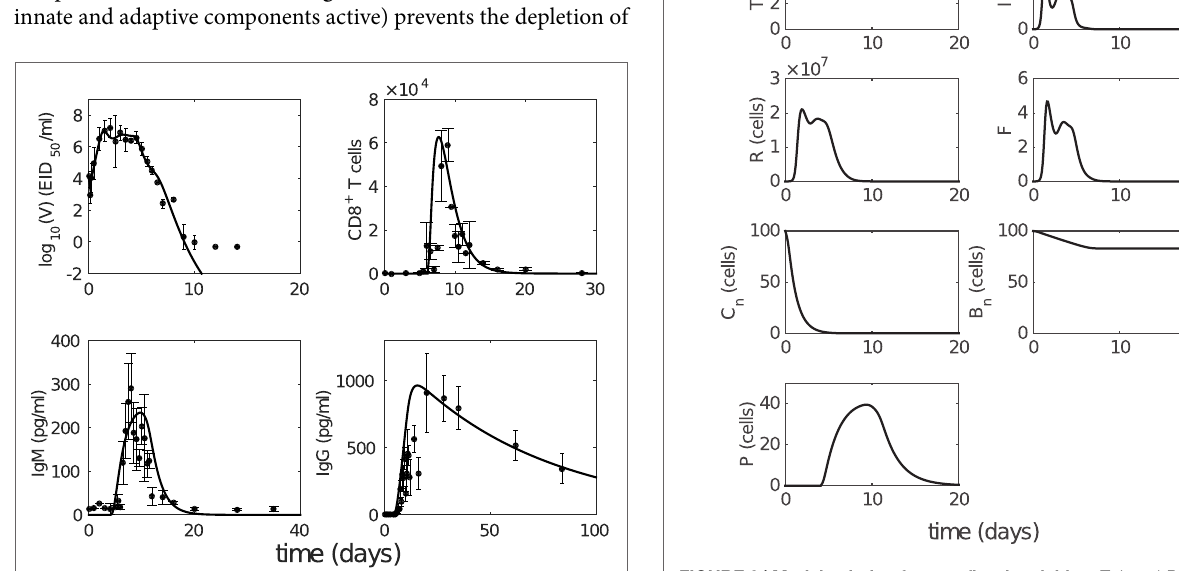
FIGURE 2 | The model with estimated parameters (solid curves) captures the murine data from the study by Miao et al. (38) . The data are shown as error bars (mean (cid:6) SD). Note that due to the limit of detection for the viral load (occurring after 10days postinfection as seen in viral load data), the last three data points in the upper left panel were not taken into consideration for model fitting.